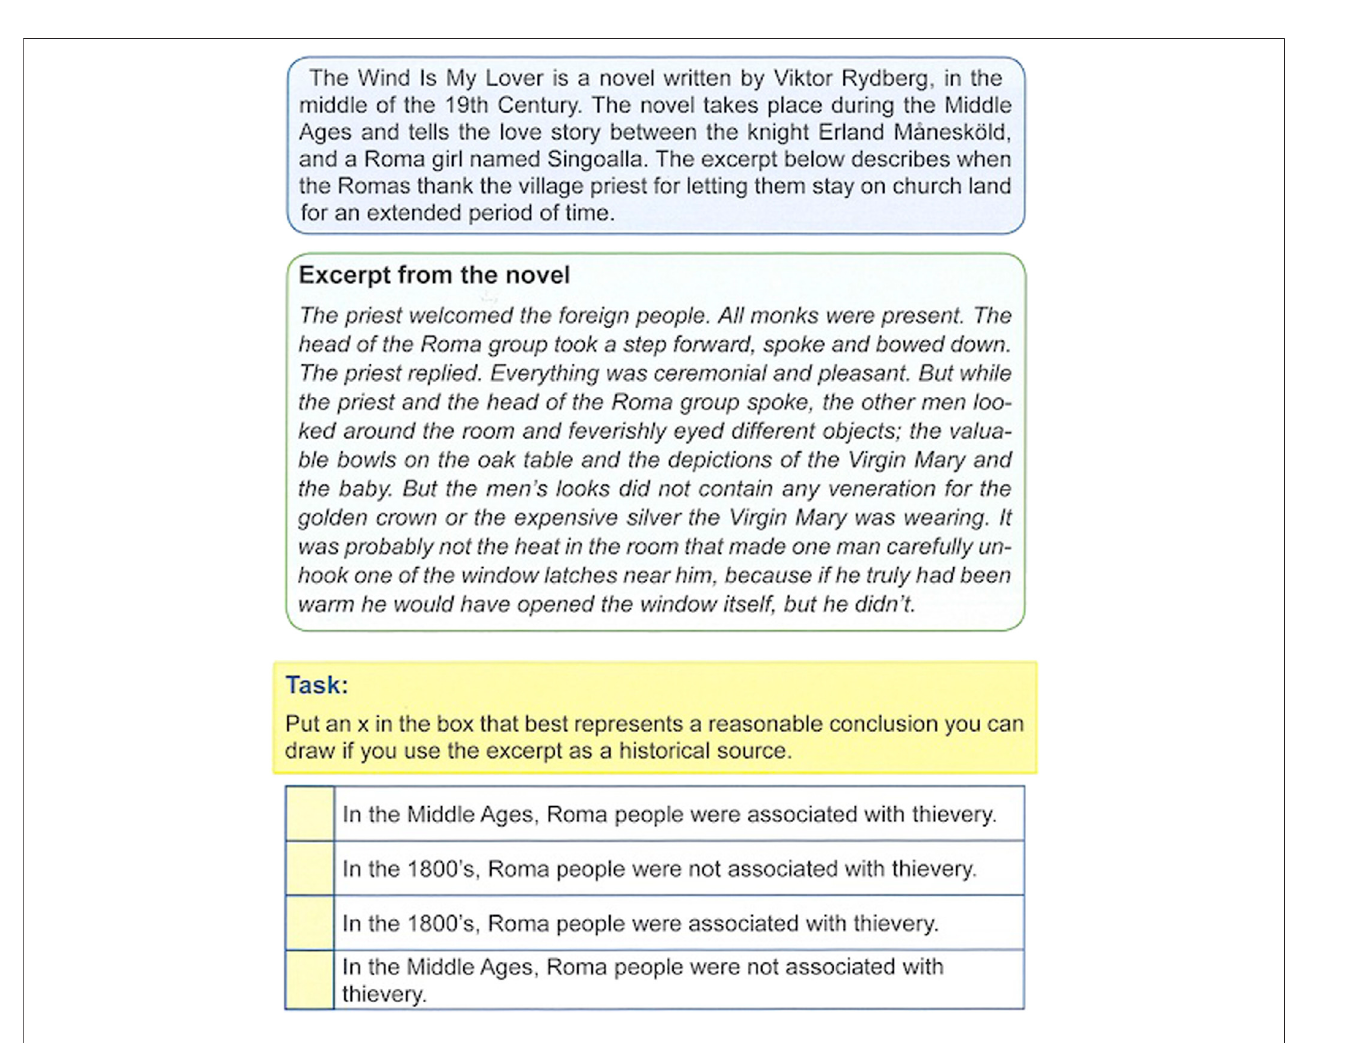
FIGURE 2 | Item no. 14 in the test from